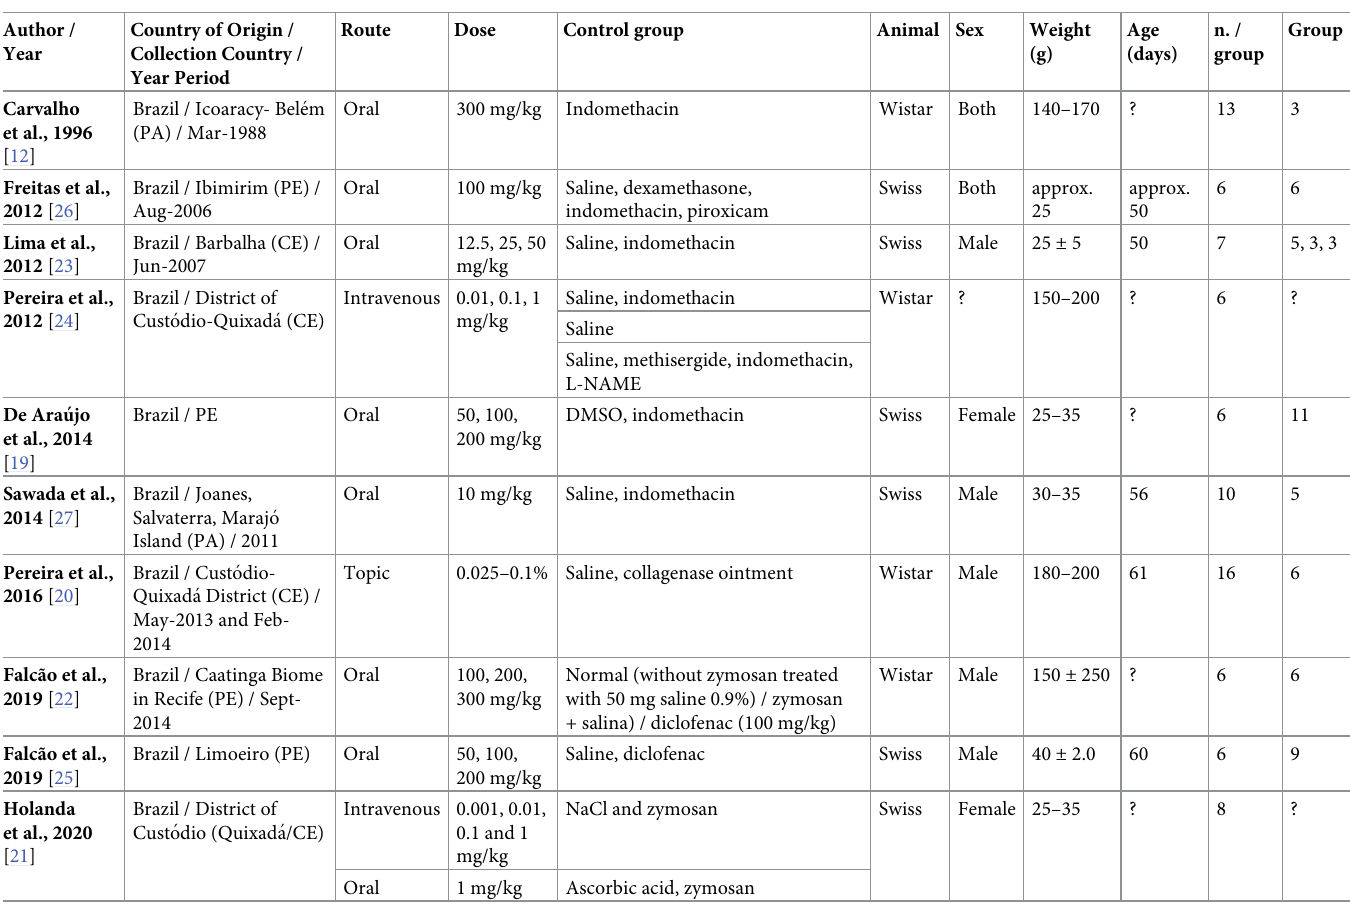
Table 2. Data from in vivo studies